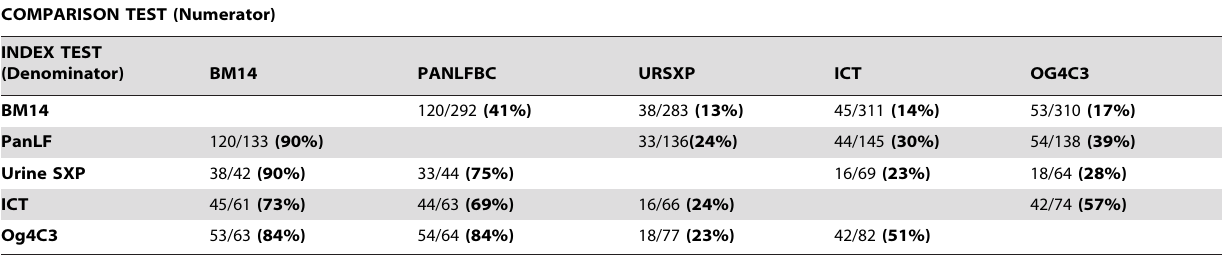
COMPARISON TEST (Numerator)